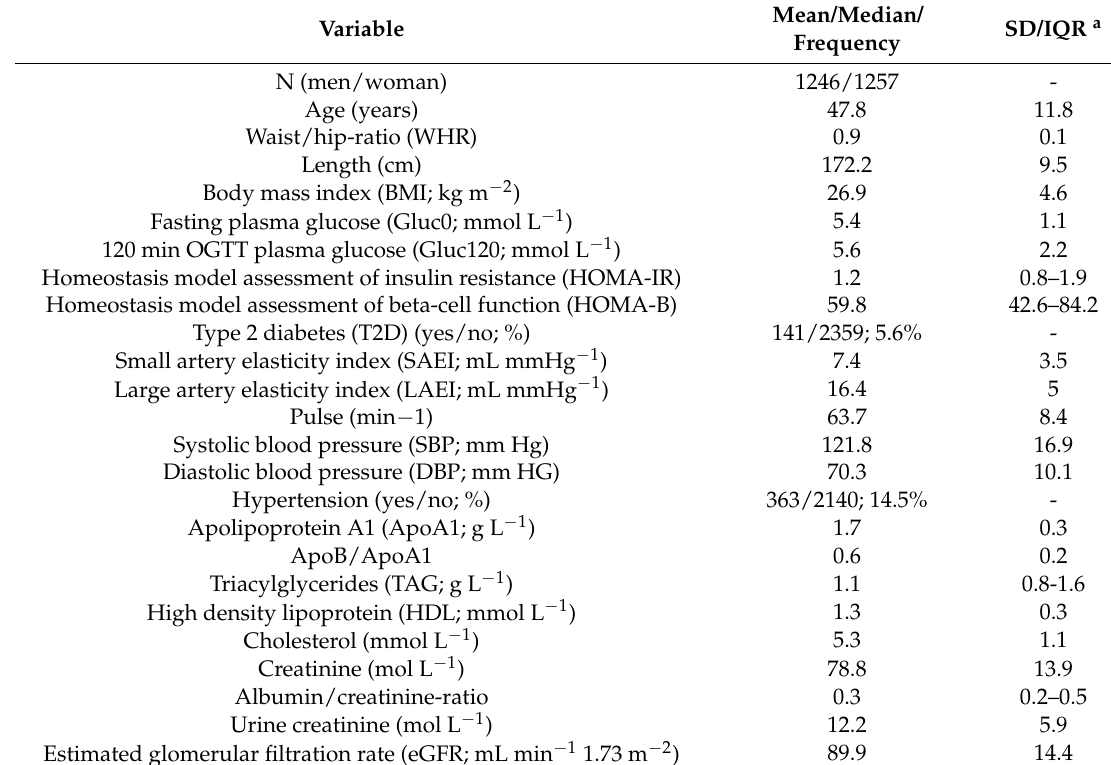
Table 1. Characteristics of the study